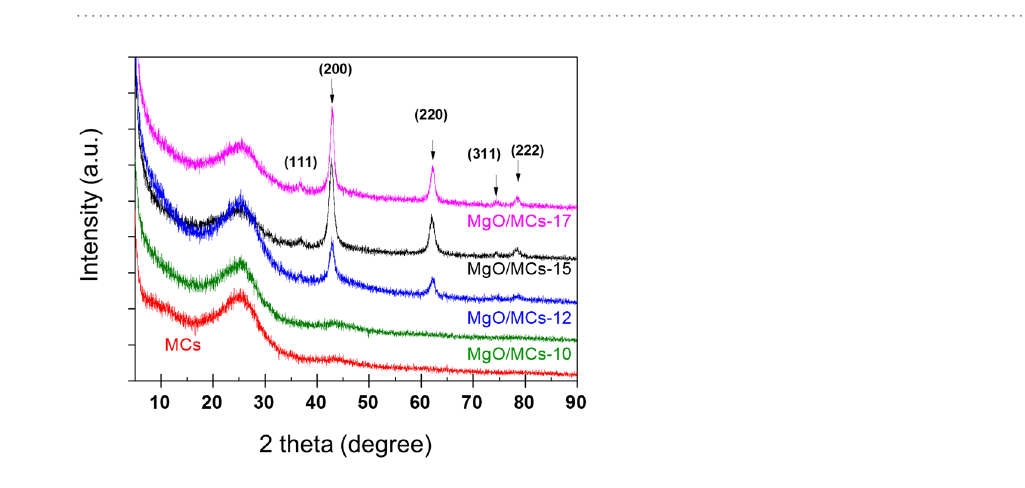
Figure 1. Schematic representation showing the synthetic route of MgO-modified microporous carbons (MgO/MCs-X). X refer to reaction time for microwave assisted urea-nitrate solution combustion synthesis.